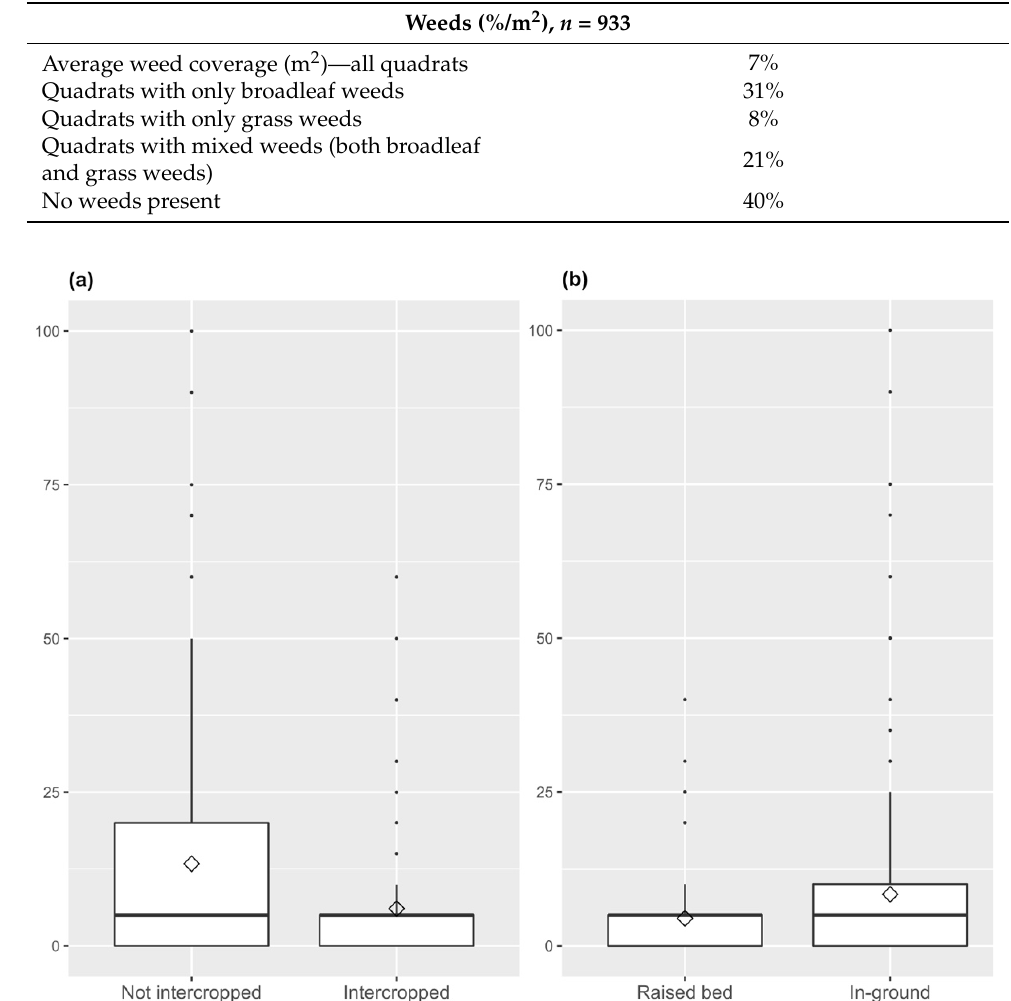
Table 3. Weed coverage in production areas.